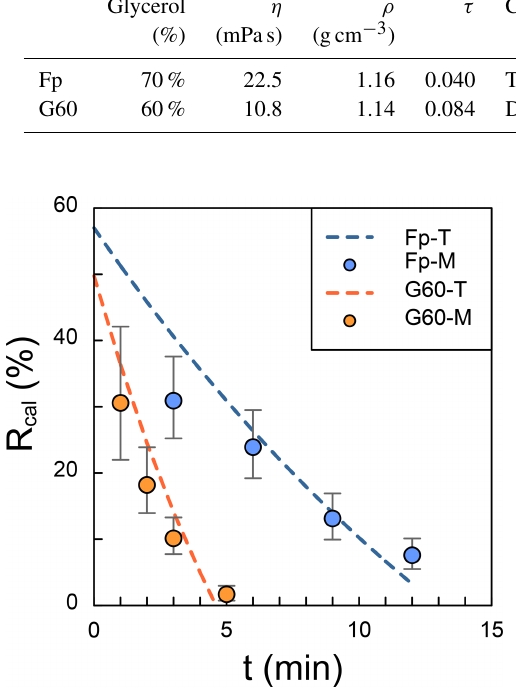
Figure 2. The comparison of theoretical and measured separation ratio ( R ): the dots represent the measured values, and dashed lines are theoretical calculations. The error bars represent 95% error based on the assumption that the error of counting coccolith follows the Poisson distribution. The orange dots represent the measured R in small Gephyrocapsa test with 60% glycerol (G60-M), and the blue ones represent the measured R in F. profunda text with 70% glycerol (Fp-M). The dashed orange line is the theoretical values for small Gephyrocapsa test with 60% glycerol(G60-T), and the blue one is the theoretical values for F. profunda test with 70% glycerol (Fp-T). Raw pictures for coccolith counting are shown in Figs. S1 and